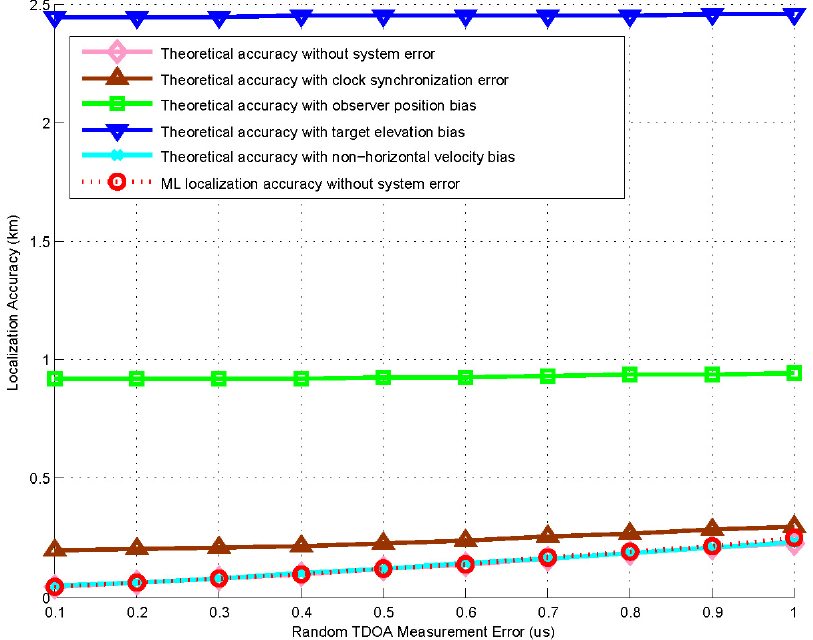
Figure 9. Localization accuracy comparison using LEO satellite, airplane and ground station by varying TDOA measurement noise.